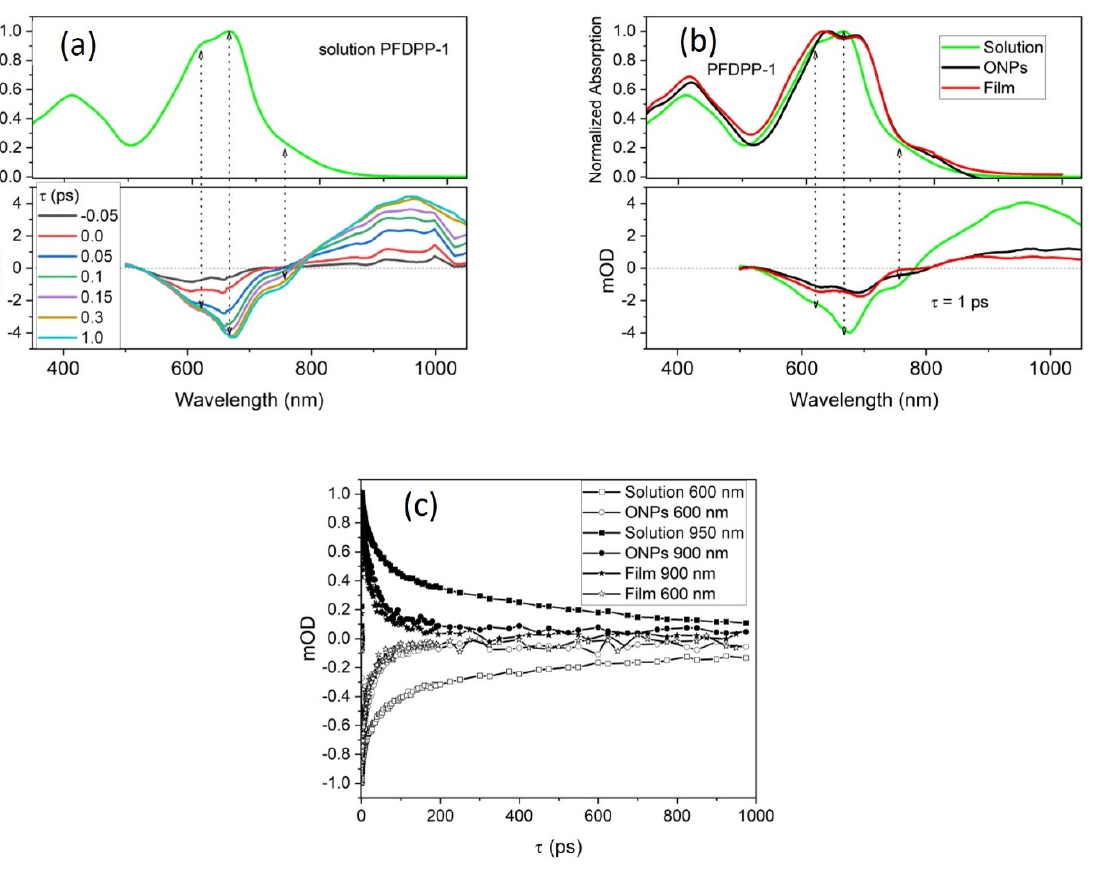
Figure 11. ( a ) TA spectra and traces for PFDPP-1 in solution, ( b ) comparison of TA spectra in solution, NPs suspension, and film at one ps after photoexcitation, ( c ) traces of TA spectra in solution, NPs suspension, and film.